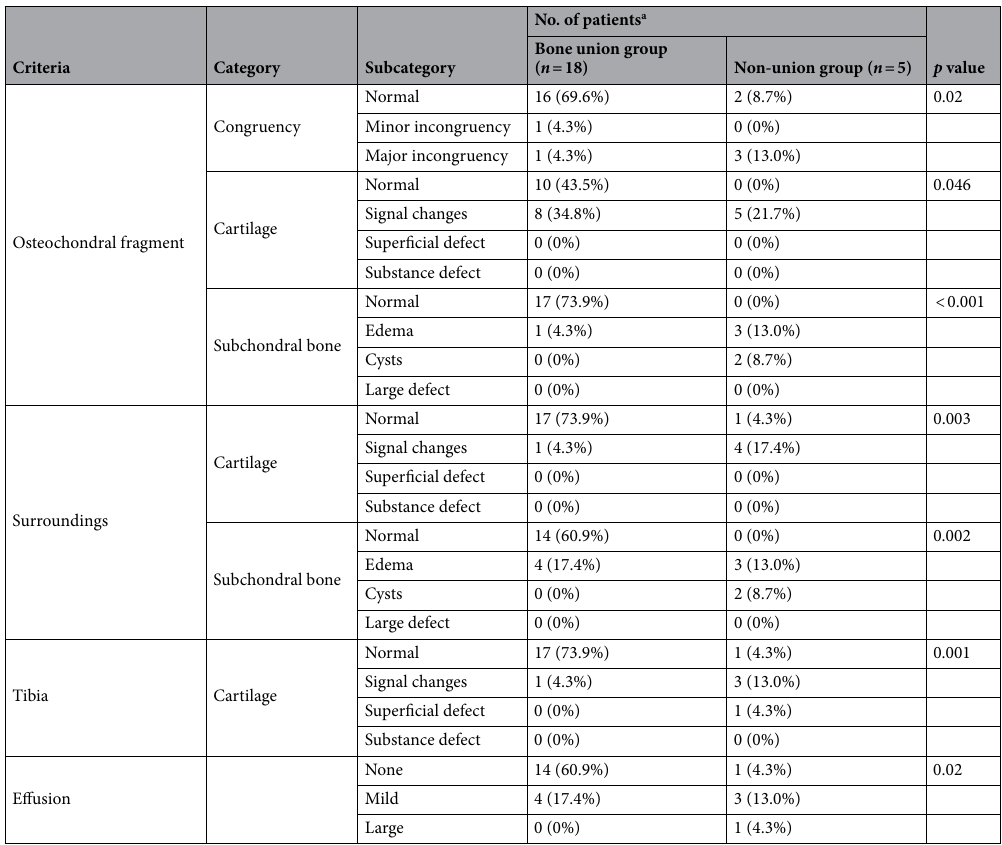
Table 3. The MRI evaluations according to the Imhoff criteria. a Values are given as the number and the percentage in